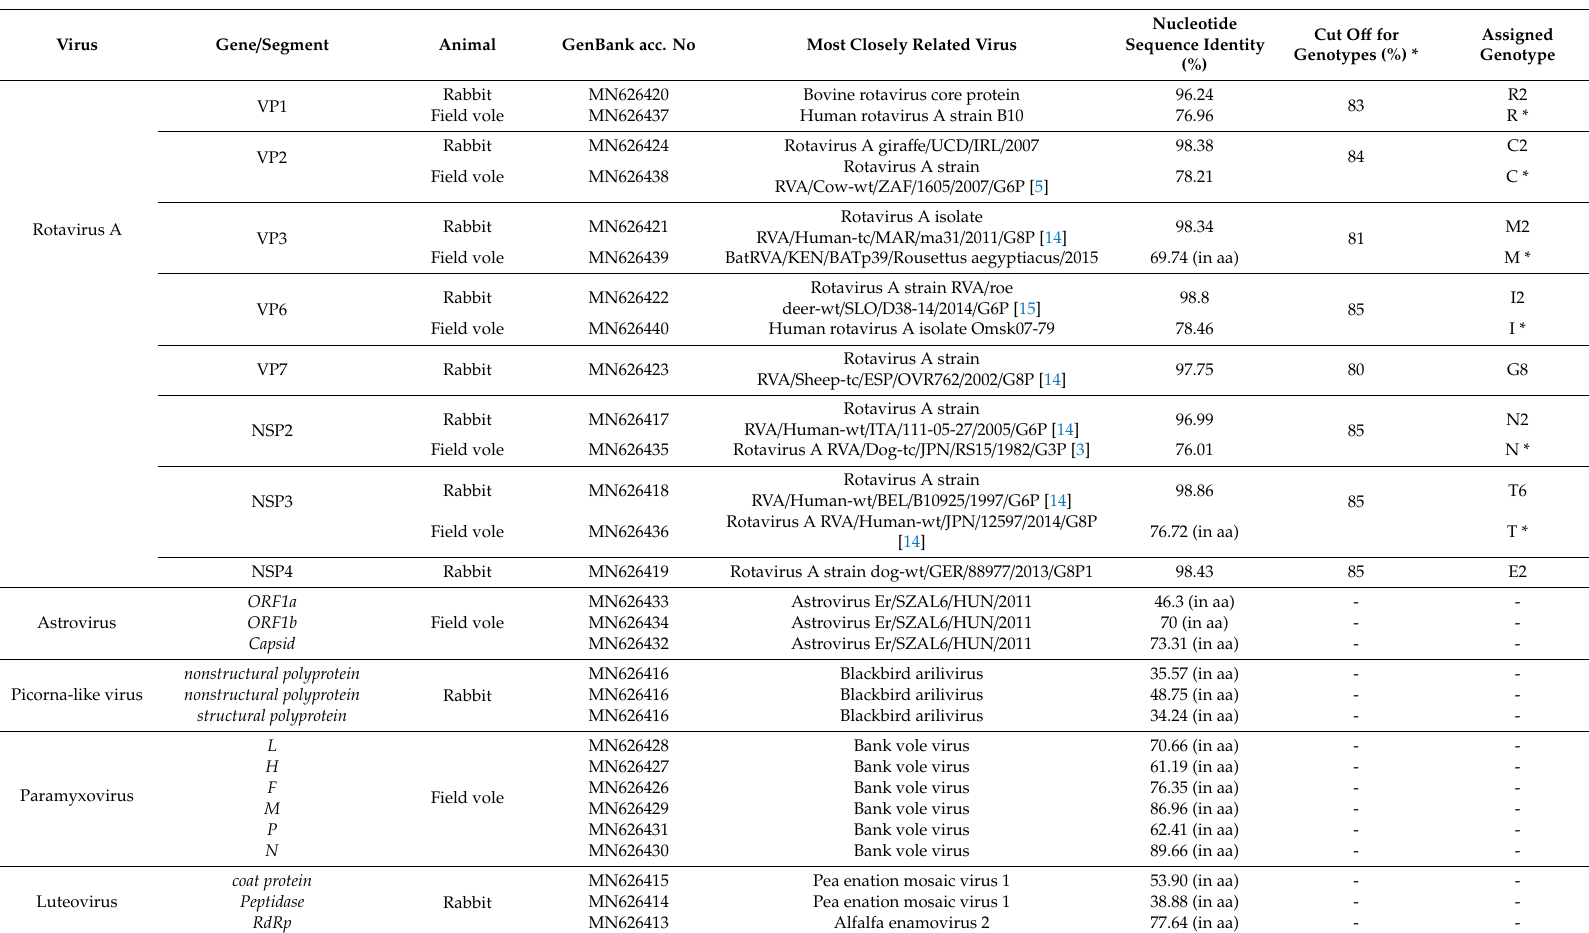
Table 2. Nucleotide and amino-acid identities of each gene / segment utilized in this study compared to the closest related viruses and the cut o ff for novel genotypes. Virus